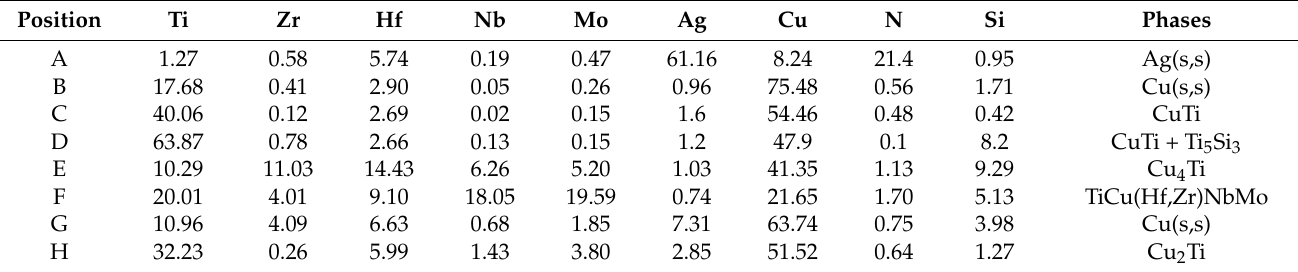
Figure 2. Typical microstructure of TiZrHfNbMo HEAs/AgCuTi/Si 3 N 4 joint brazed at 840 °C for 60 min. ( a ) Typical interfacial microstructure, ( b ) zone III, ( c ) interfacial microstructure of zone I and zone II, ( d ) interfacial microstructure of zone I and zone III, ( e ) and ( f ) Enlarged drawing of two areas in ( d ). Table 1. EDS analysis of phases in Figure 2 (at. %).